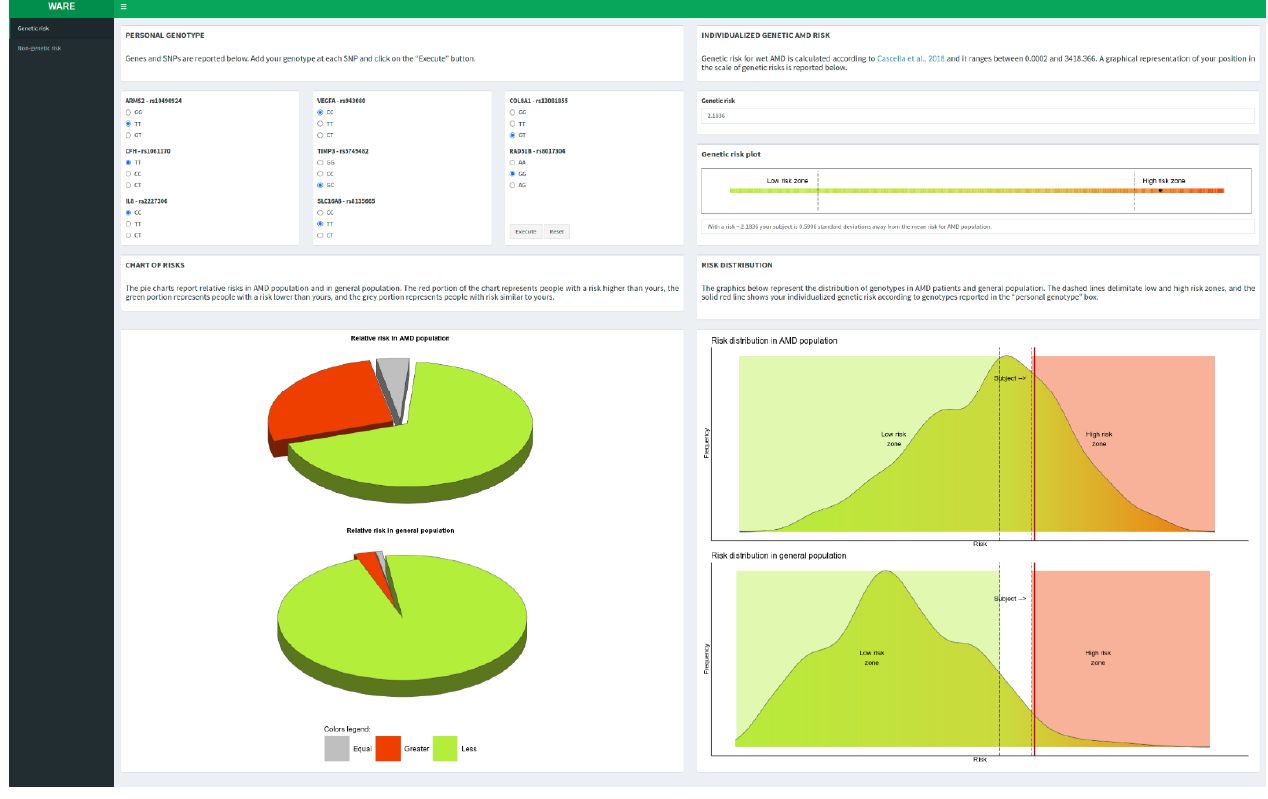
Figure 1. Genetic risk tab [16].